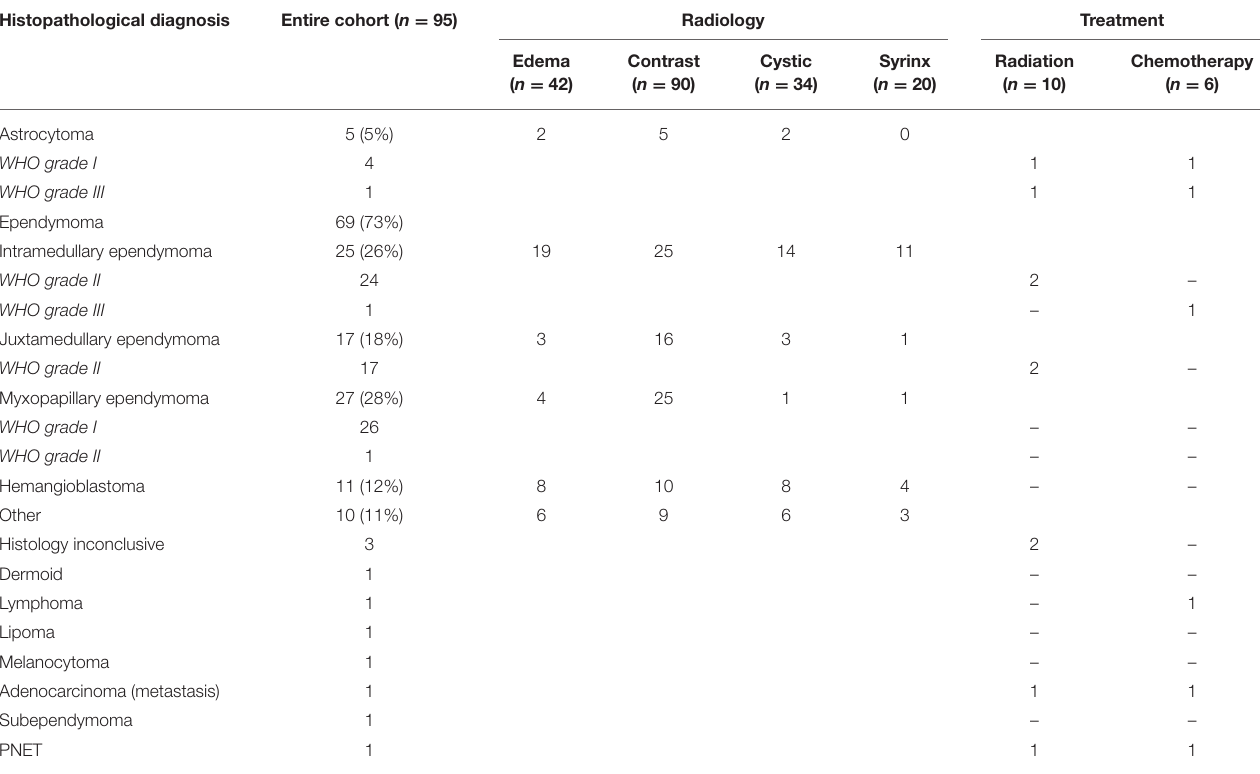
TABLE 3 | Histopathological diagnosis, radiologic signs, and adjuvant treatment. Histopathological diagnosis Entire cohort ( n = 95) Radiology